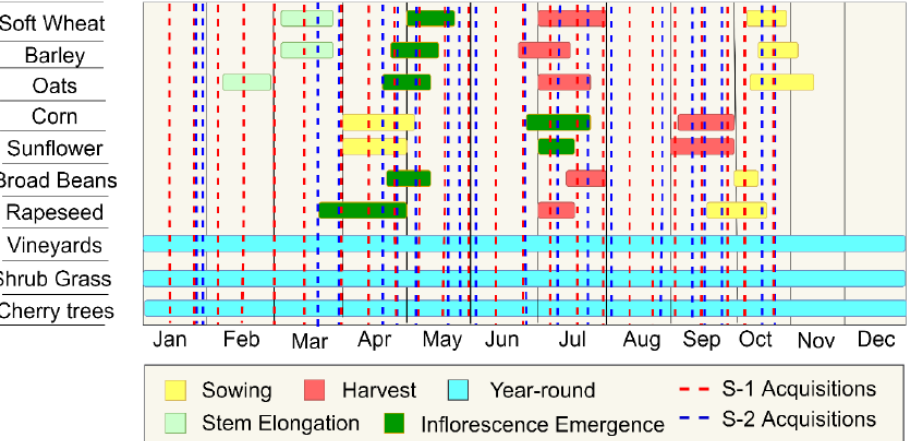
Figure 2. A timeline of the growth stages of the major crops in the study area, reworked from [96], presented with Sentinel-1 (red color) and Sentinel-2 (blue color) acquisition